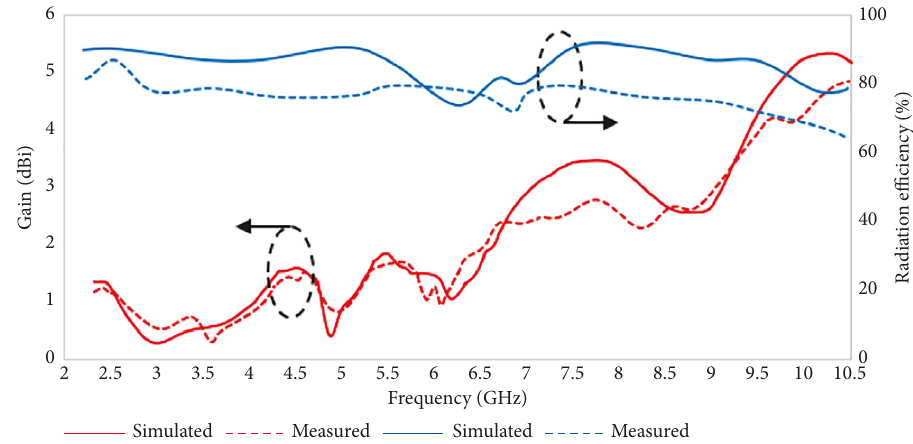
Figure 6: Simulated vs. measured gain and radiation efficiency over frequency plot of all operating bands.